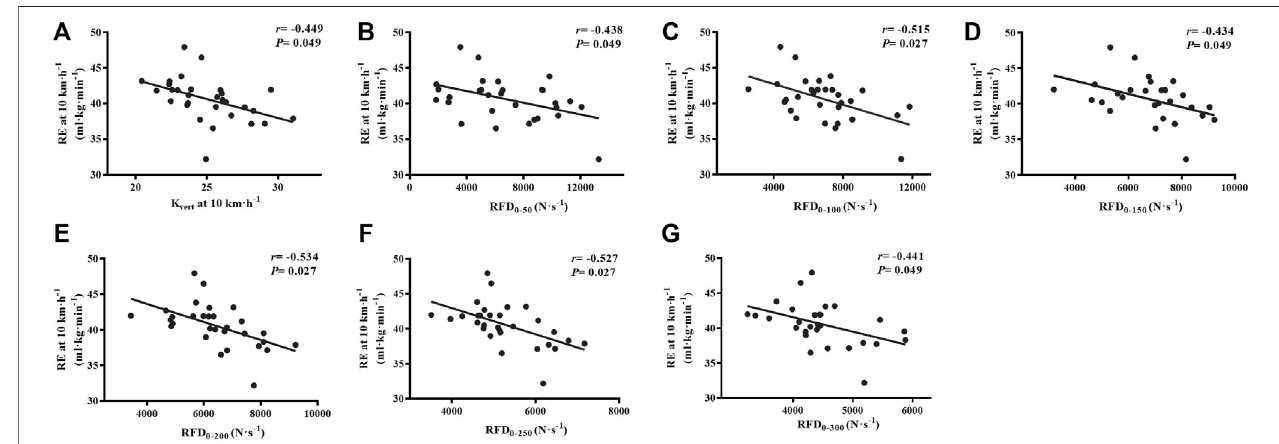
FIGURE 4 | Correlations of K vert , IMTP force-time characteristics with 10 km · h − 1 (A – G) running economy. K vert , vertical stiffness; RFD, rate of force development; RFD 0 – 50 , RFD 0 – 50 ms; RFD 0 – 100 , RFD 0 – 100 ms; RFD 0 – 150 , RFD 0 – 150 ms; RFD 0 – 200 , RFD 0 – 200 ms; RFD 0 – 250 , RFD 0 – 250 ms; RFD 0 – 300 , RFD 0 – 300 ms; RFD 0 – 350 , RFD 0 – 350 ms; IMTP, isometric mid-thigh